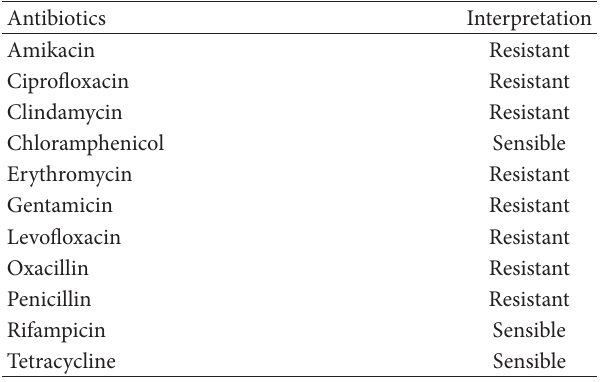
Table 3: Antibiogram: MRSA.